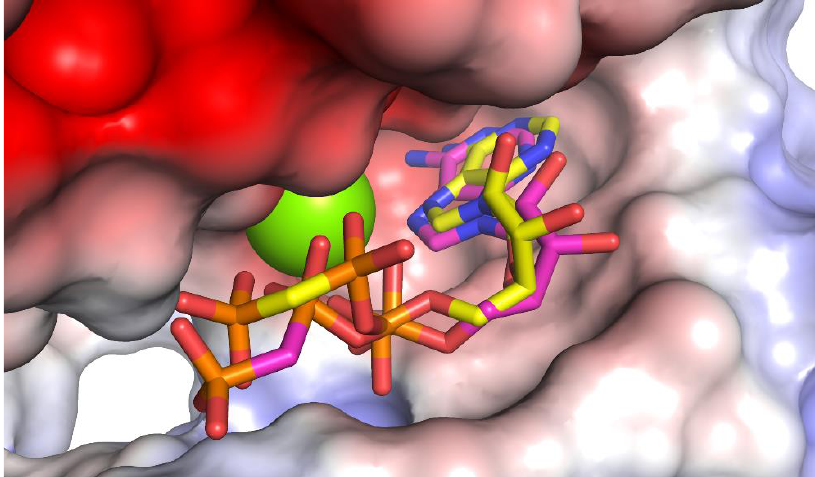
Figure 2. Validation of docking procedure by redocking of AMP-PCP ligand (yellow). The docking pose predicted (pink) is relatively similar to the crystal structure with an RMSD of 1.472 Å. Magnesium ion in the active site is shown as the green sphere.